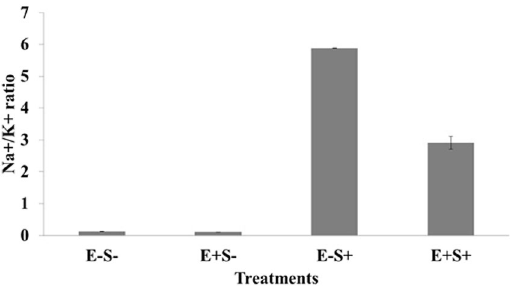
Figure 3. Na + /K + ratio of 10 day old IR-64 seedlings subjected to different treatments. Line over bars indicates SEm ( ± ). Legend to X-axis is same as given in Fig.